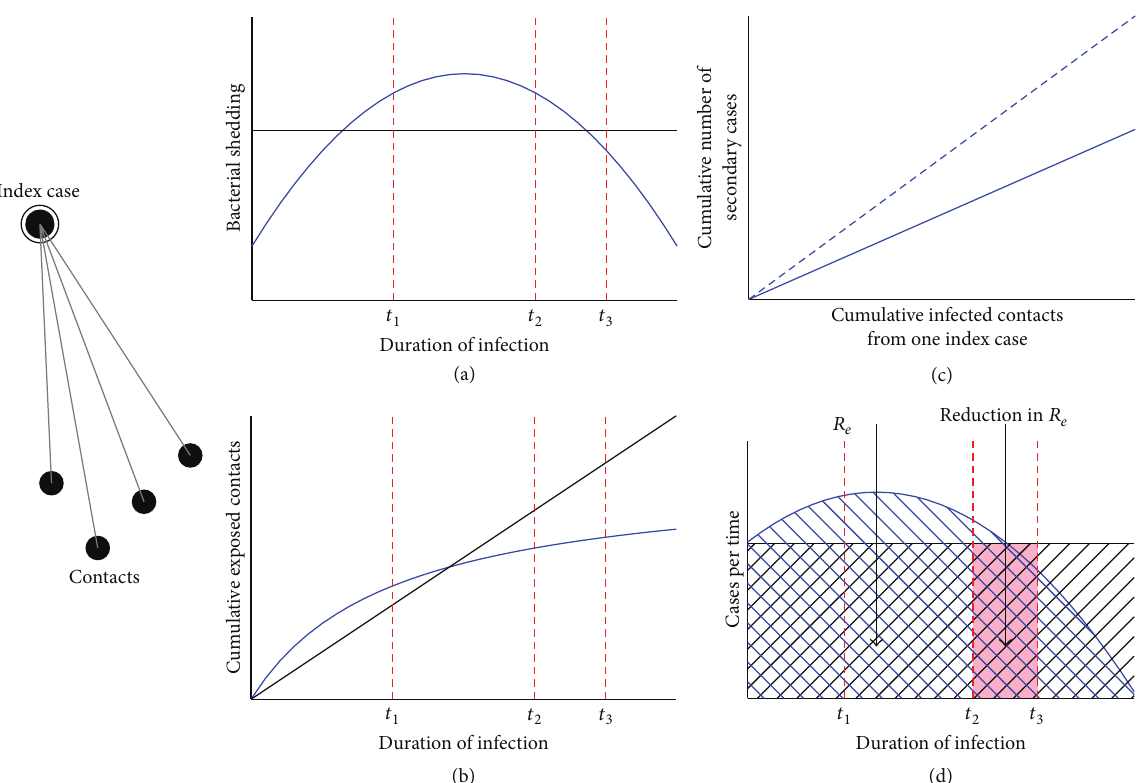
Figure 2: (a) The rate of bacterial shedding over the duration of infection may be a constant function (black line) or change over time (blue line). (b) The cumulative number of contacts exposed to TB over the duration of infection may increase linearly over time (black line) or may plateau as contact pool becomes saturated or patient is too ill to circulate in the community. The potential impact of a novel intervention may depend on this assumption; given a linear increase, earlier intervention ( 𝑡 1 ) would be likely preferred. While given the second curve with only a small increase and plateau, the impact between intervening at 𝑡 1 and 𝑡 2 might not be as great; therefore other factors including cost-effectiveness may come into play. (c) The cumulative number of secondary cases resulting from one index case in relation to the number of cumulative infected contacts: there are factors associated with bacterial virulence and host susceptibility that impact the rate of progression from infection to disease. This rate may be steeper among immunosuppressed contacts, for example, (dotted line) compared with immunocompetent contact (solid line). (d) The effective reproductive number ( 𝑅 𝑒 ) is the number of secondary cases generated over a given time period. Bacterial shedding, contact mixing pattern, and bacterial and host susceptibility all contribute to the overall rate of secondary cases generated over time; depending on what assumptions are made these rates could be thought to stay constant over time or vary, perhaps tapering off over the duration of infection. By reducing the time to diagnosis and treatment initiation we hope to reduce the number of secondary cases but the amount of impact depends on assumptions around the shape of the curve over time. The hashed area represents the secondary cases generated from one index case while the shaded area represents the potential reduction in secondary cases given an intervention at 𝑡 2 . Figure adapted with permission from Dowdy et al.